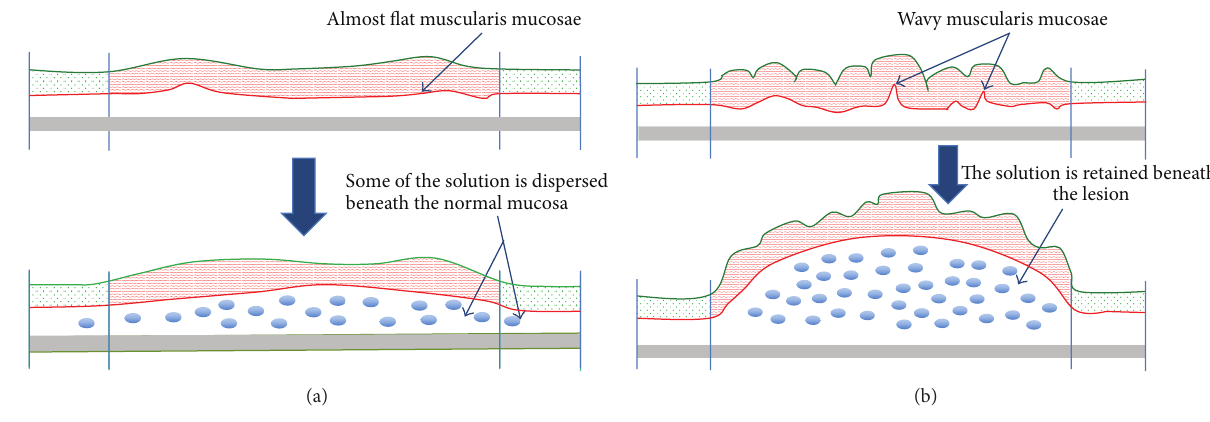
Figure 5: Representation of laterally spreading tumors before and after the injection of a solution into the submucosal layer. (a) The almost flat muscularis mucosae of LST-NGs may lead to disperse the solution, elevating not only the lesion but also the surrounding mucosa. (b) In contrast, the wavy disposition of the muscularis mucosae of LST-Gs may facilitate to retain the solution beneath the lesion, elevating consequently the lesion and making propitious for EMR or